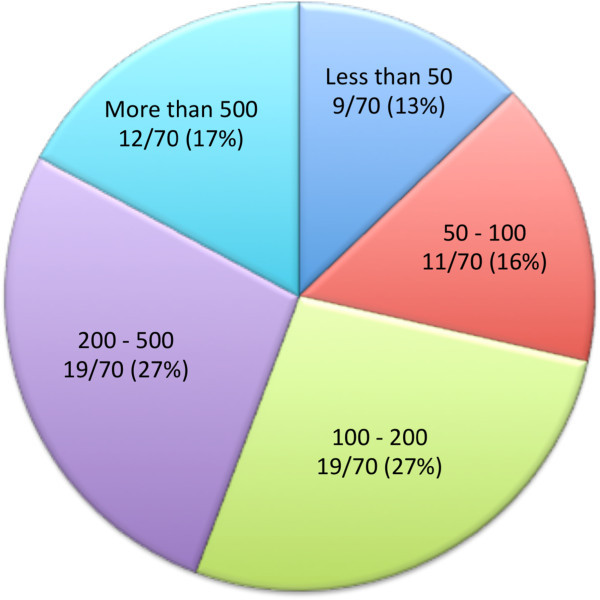
 Number of pediatric CMRs performed each year. Respondents who performed “100-200” and “200-500” pediatric CMRs each made up 27% of all respondents. This is followed by “more than 500” (17%), “50-100” (16%), and “less than 50” (13%).